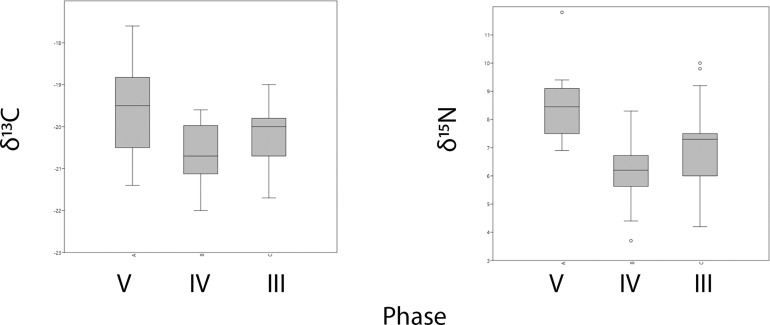
Means and variation of δ13C and δ15N values from collagen by phase.